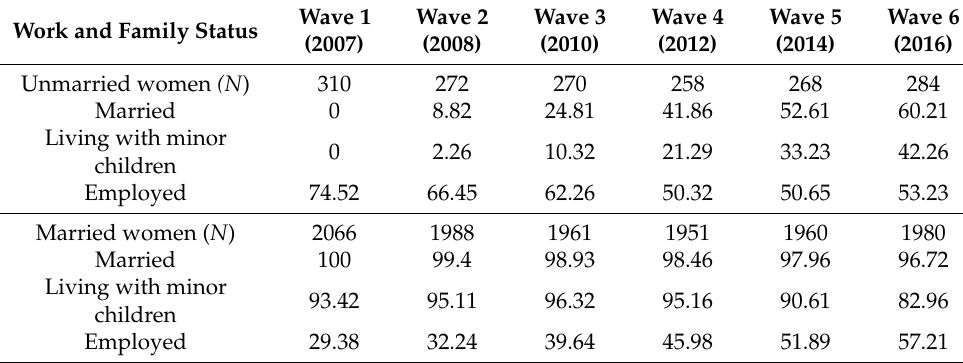
Table 1. Percentages of women in each work and family status at each